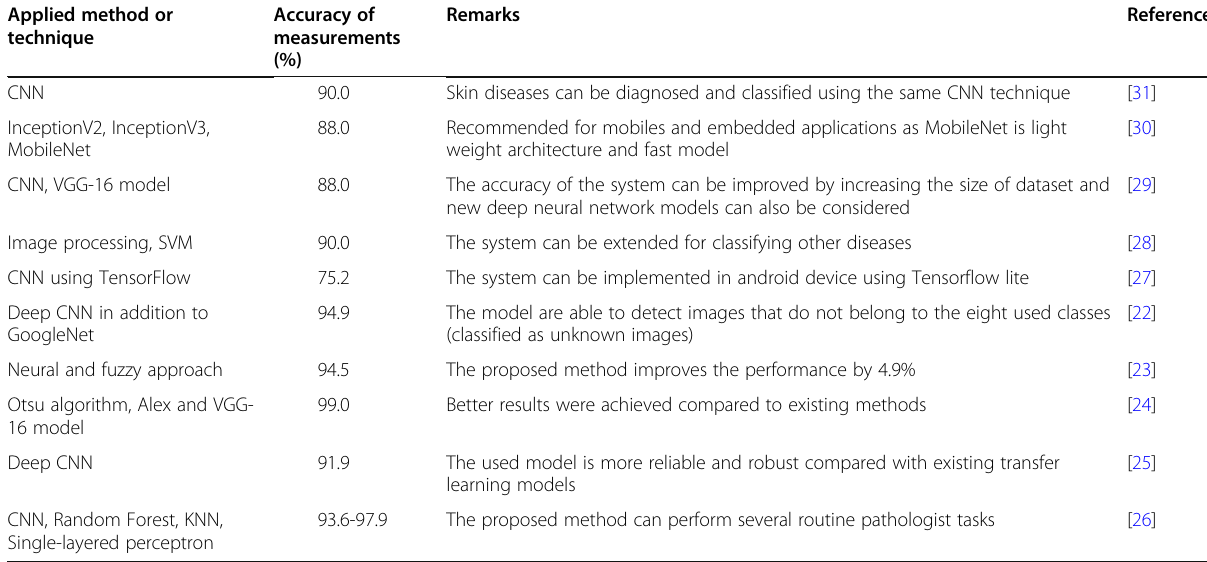
Table 1 Different image classification methods Applied method or